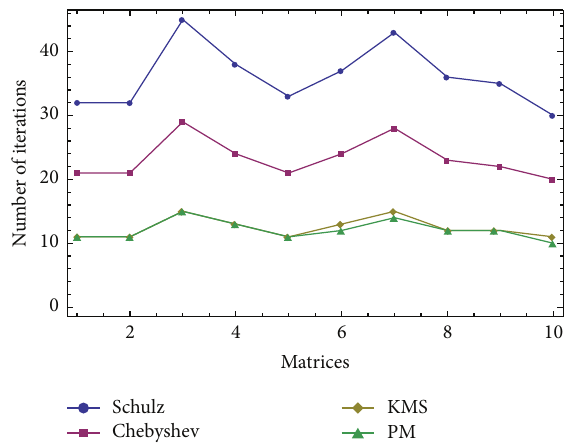
Figure 3: Comparison of the number of iterations for solving Example 9.